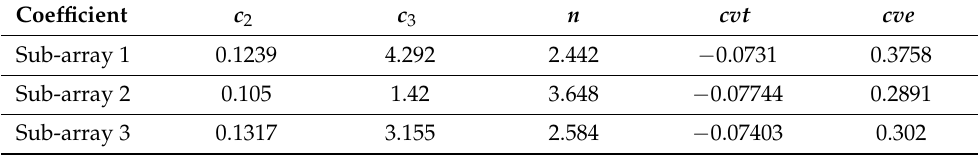
Table 5. Empirically identified parameters used to predict DC voltage using sandia model.